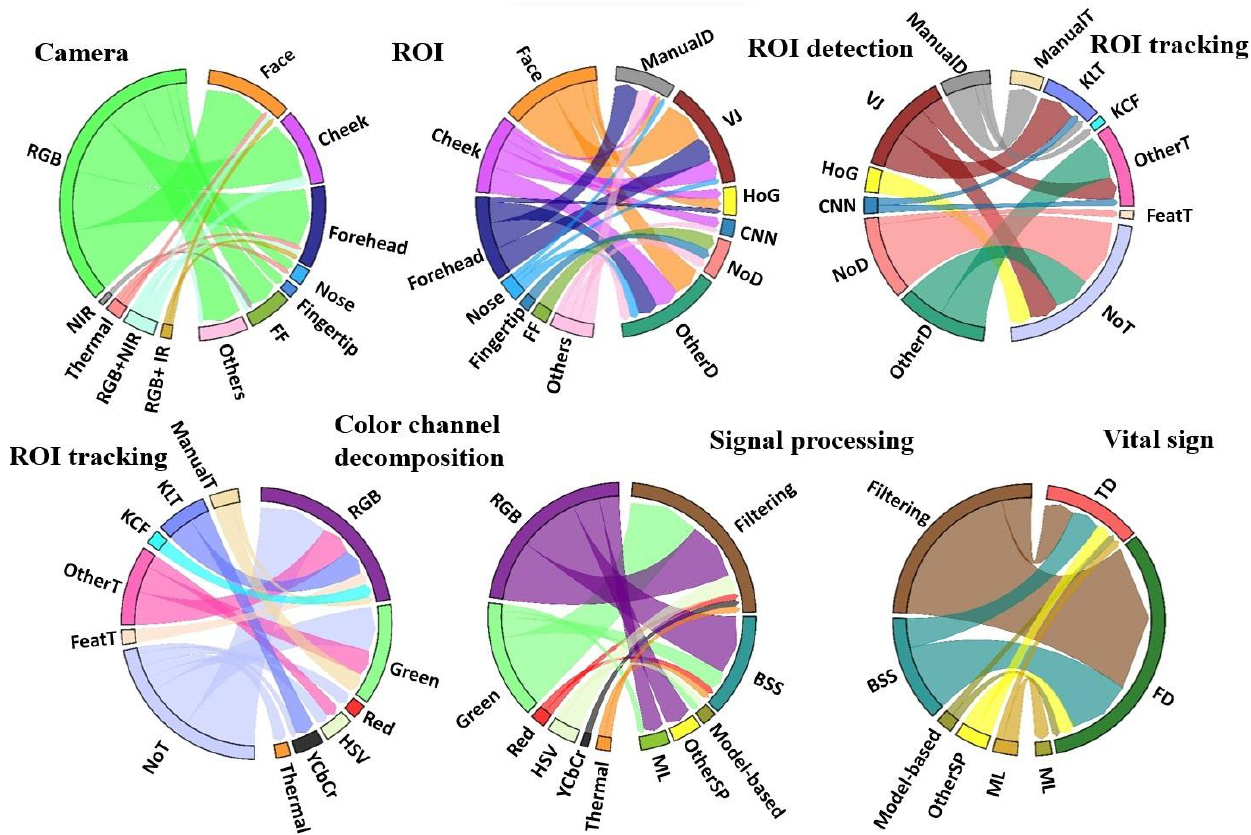
Figure 8. Comprehensive work flow from various camera images to HR vital sign (Note: FF: full